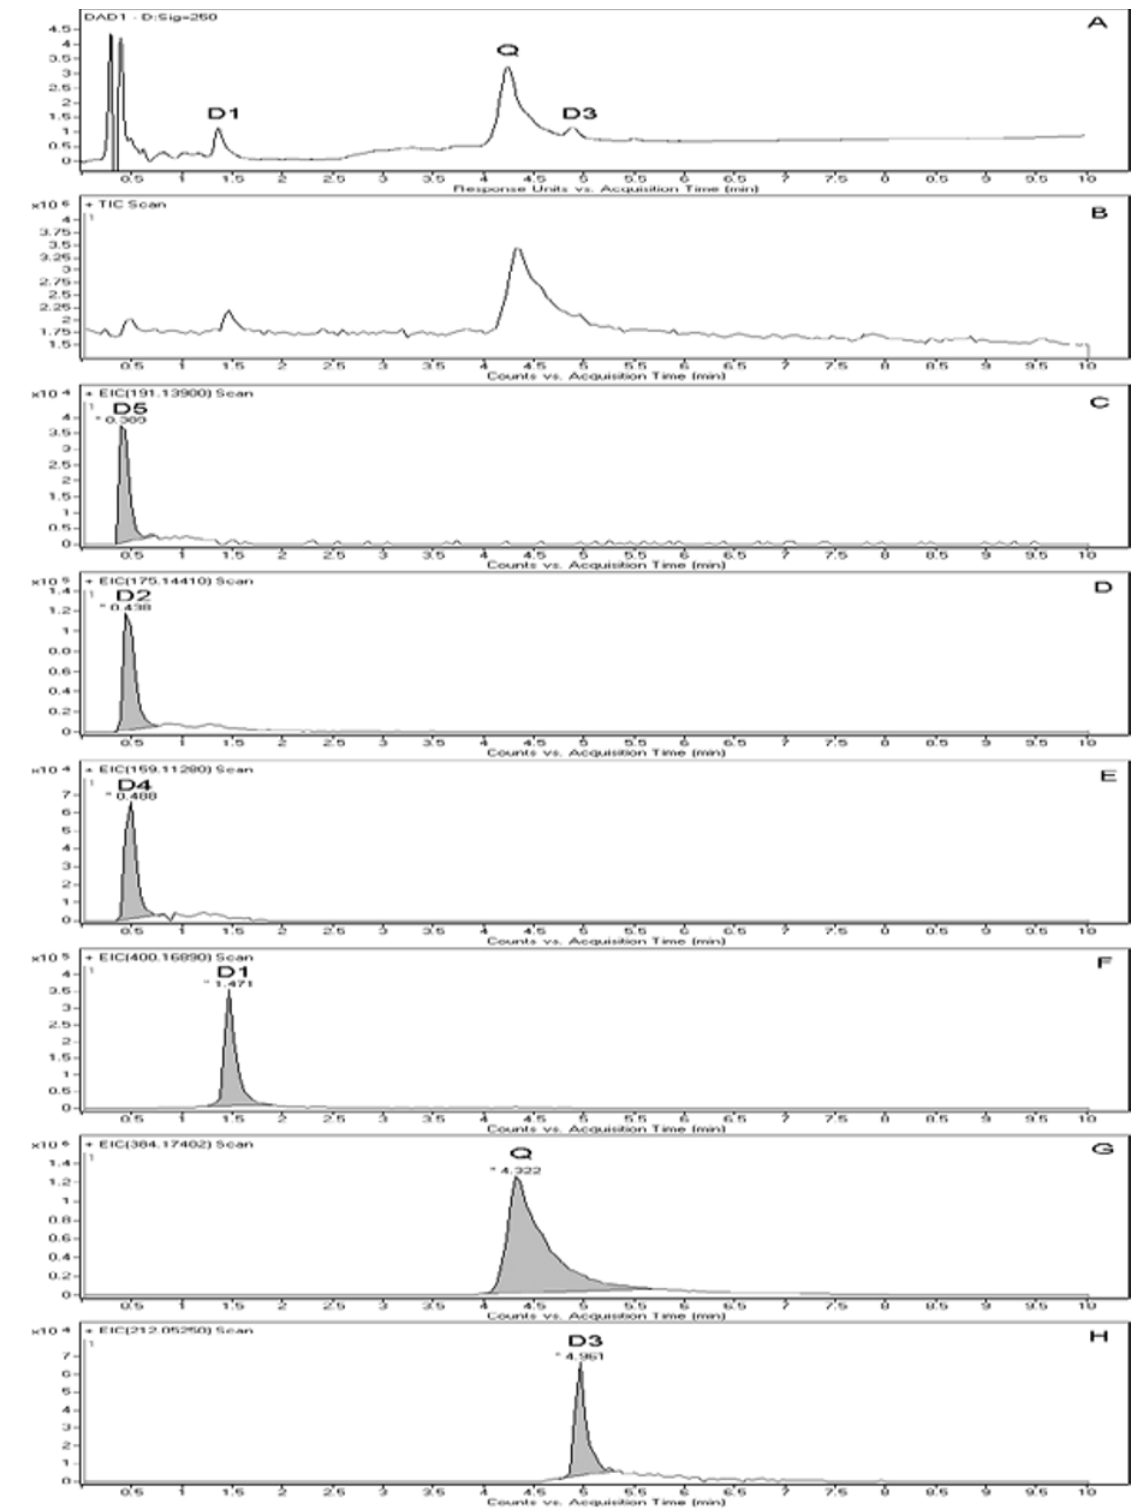
Figure 1. UHPLC DAD chromatogram (A), Q-TOF total ion chromatogram (B) and extracted ion chromatograms (C-H) obtained from quetiapine (Q) methanolic solution after 6 h UVC irradiation; D1-D5 – photodegradation